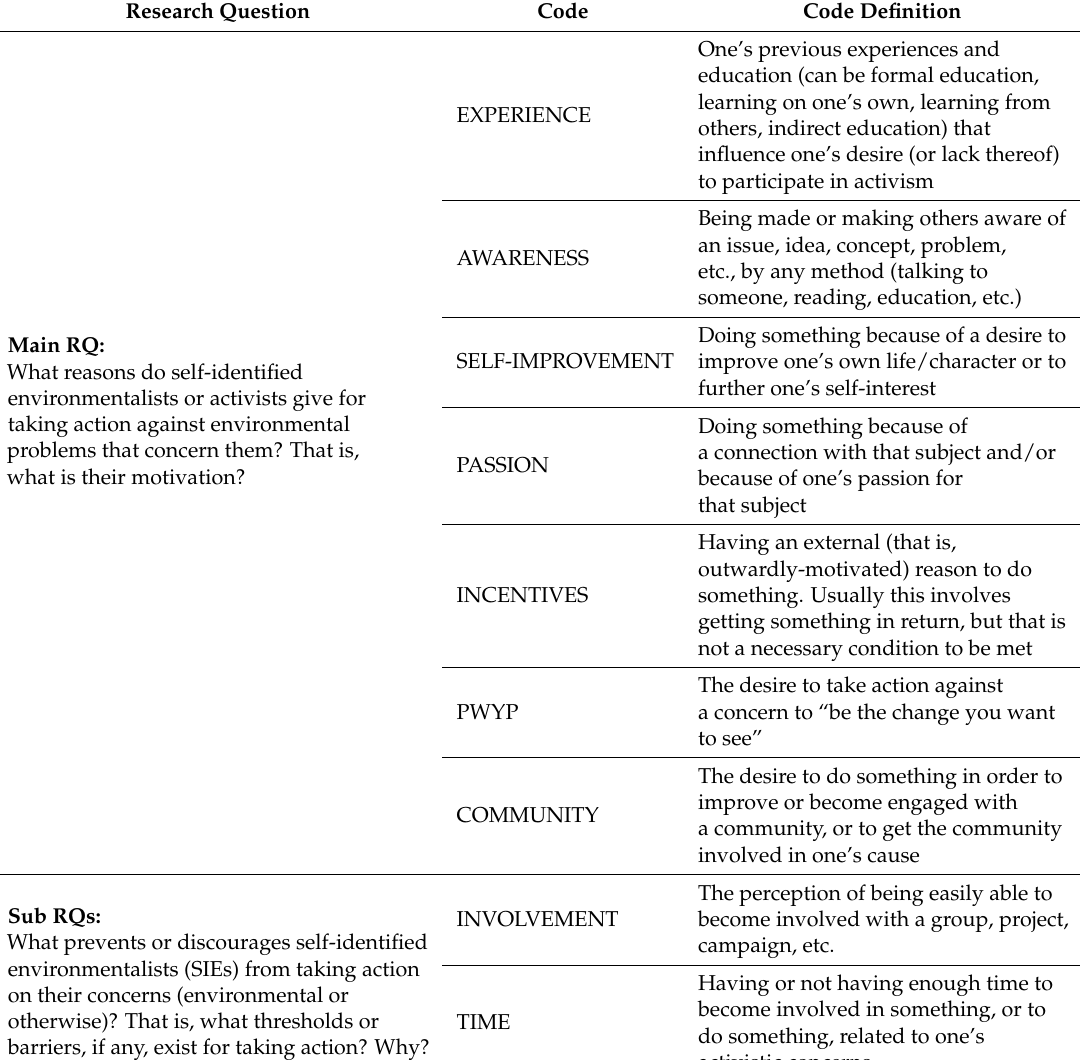
Table 1. Research questions and relevant codes and